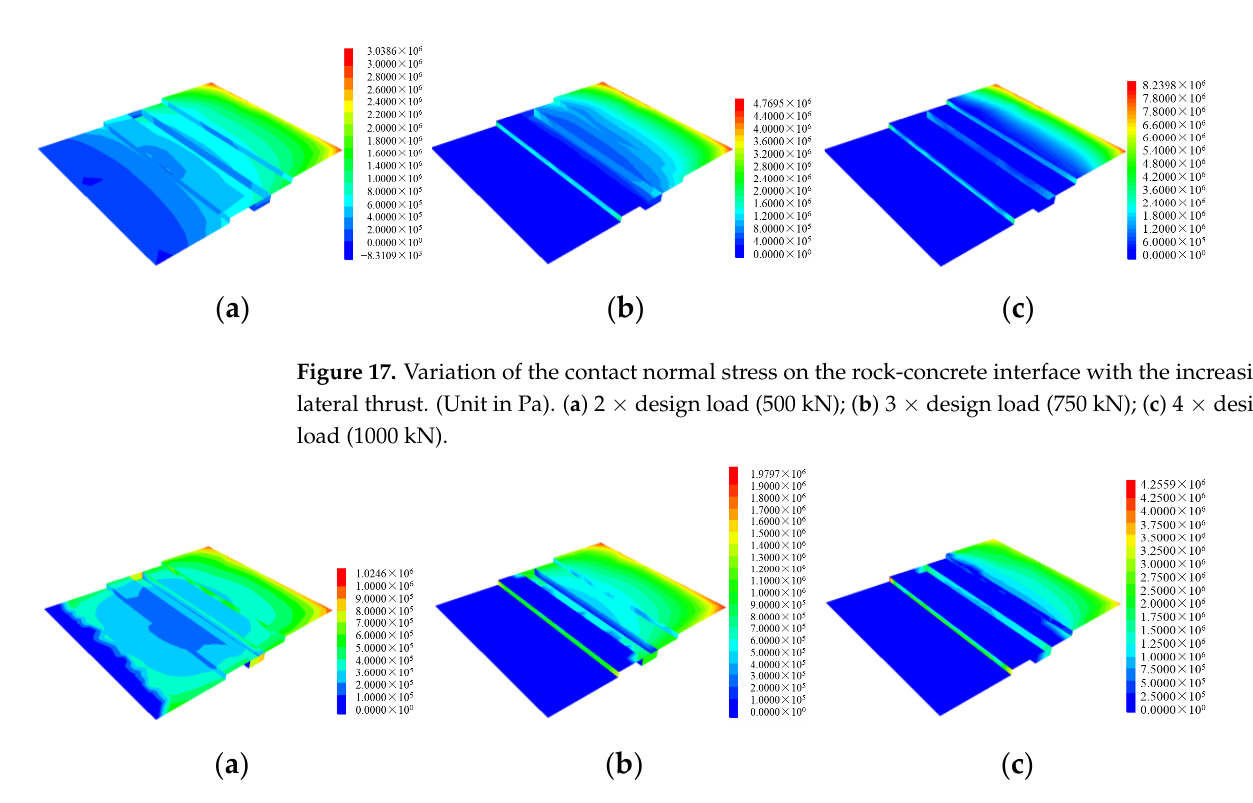
Figure 18. Variation of the contact shear stress on the rock-concrete interface with the increasing lateral thrust. (Unit in Pa). ( a ) 2 × design load (500 kN); ( b ) 3 × design load (750 kN); ( c ) 4 × design load (1000 kN).